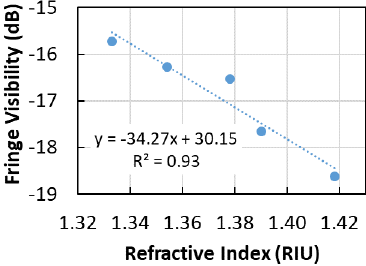
Figure 6. (a) Reflected signal for the FP ‐ short sensor ( L 1 = 105 μ m and L 2 = 149 μ m) and (b) the resulting spectral analysis.